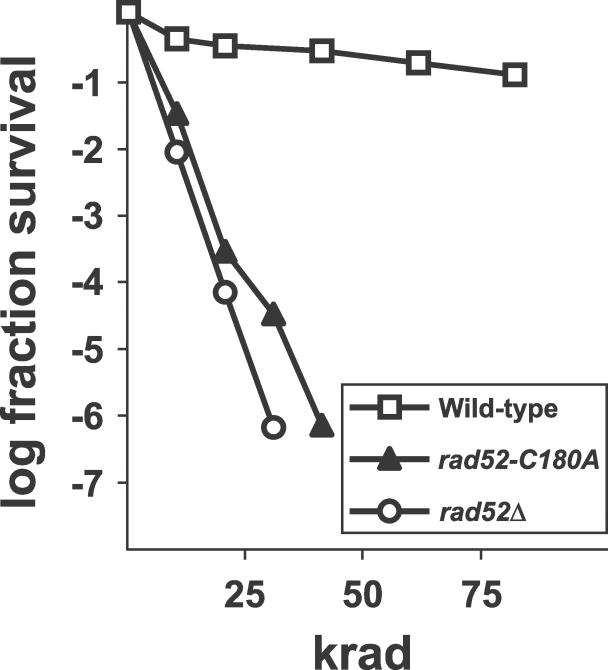
γ-Ray Sensitivity of rad52-C180A, rad52Δ, and Wild-Type Strains